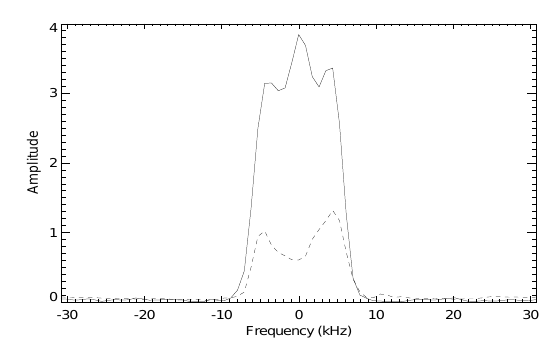
Fig. 11. As for Fig. 10, but at 5.2MHz for 13:07–13:09 UT, 27 April